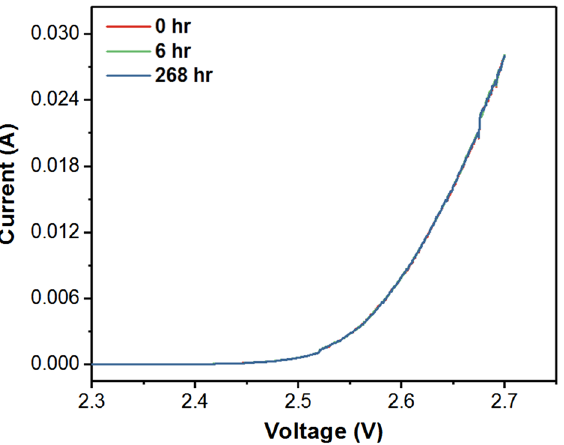
Figure 4. I-V characteristics of LEDs tested under ambient conditions at different time intervals.